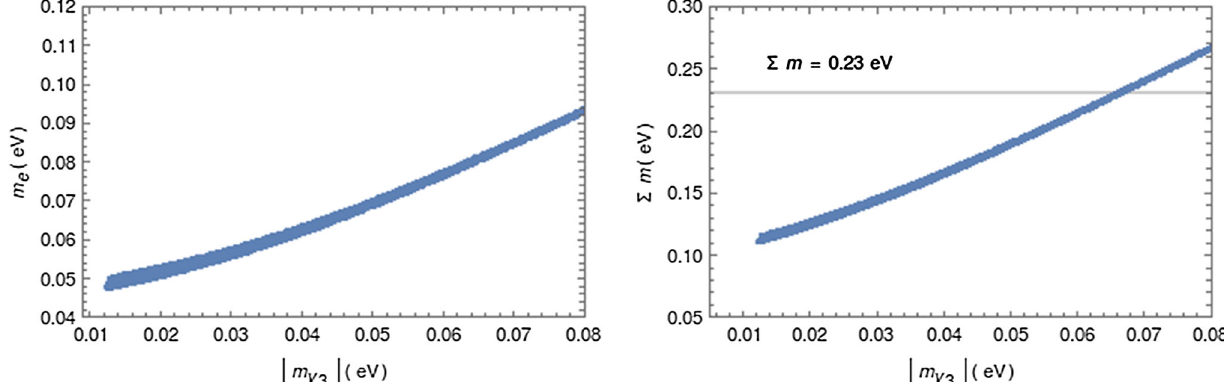
| and | (cid:4) | , respectively 3